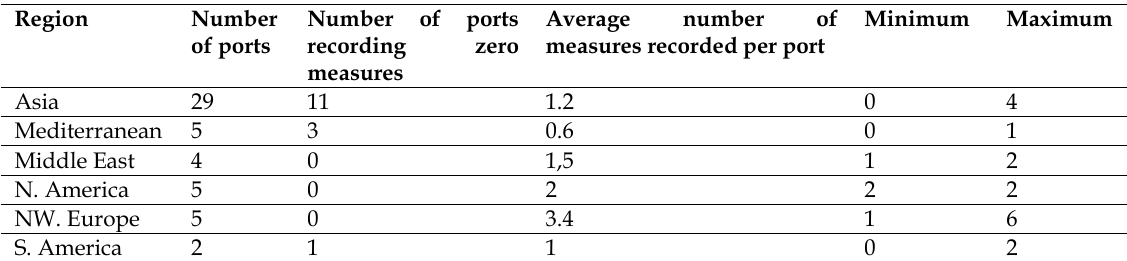
Regional breakdown of findings